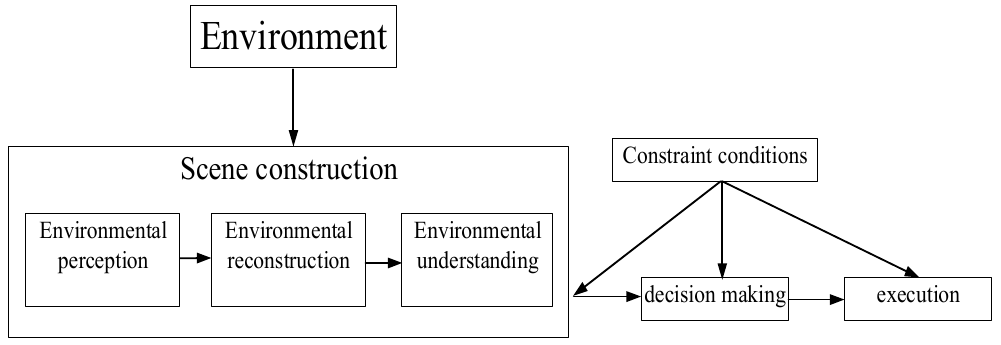
Figure 2. The framework for the mission planning of multi ‐ UAVs.